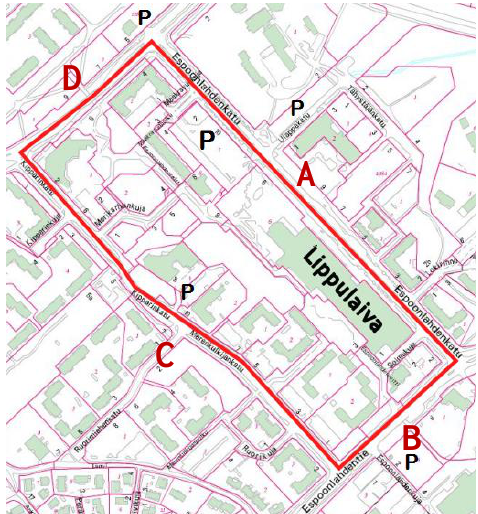
Figure 1. Espoonlahti test field. Driving route is marked with red line, and sections are marked with red letters A-D. Parking spaces are marked with P. (Background map data © City of Espoo.)